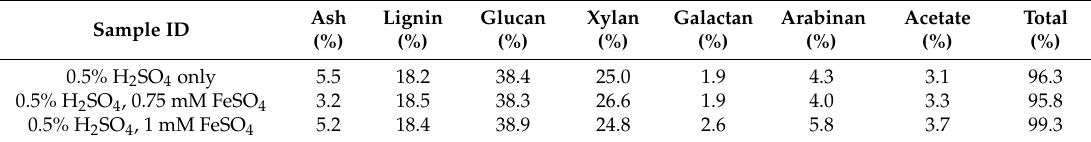
Table 1. Solids compositional analysis of acid-only and acid cocatalyst-soaked corn